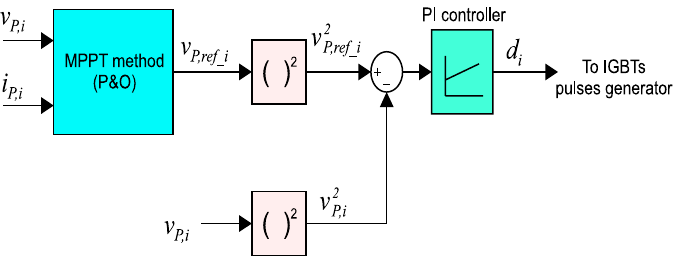
Figure 11. MPPT control scheme for each PV module.